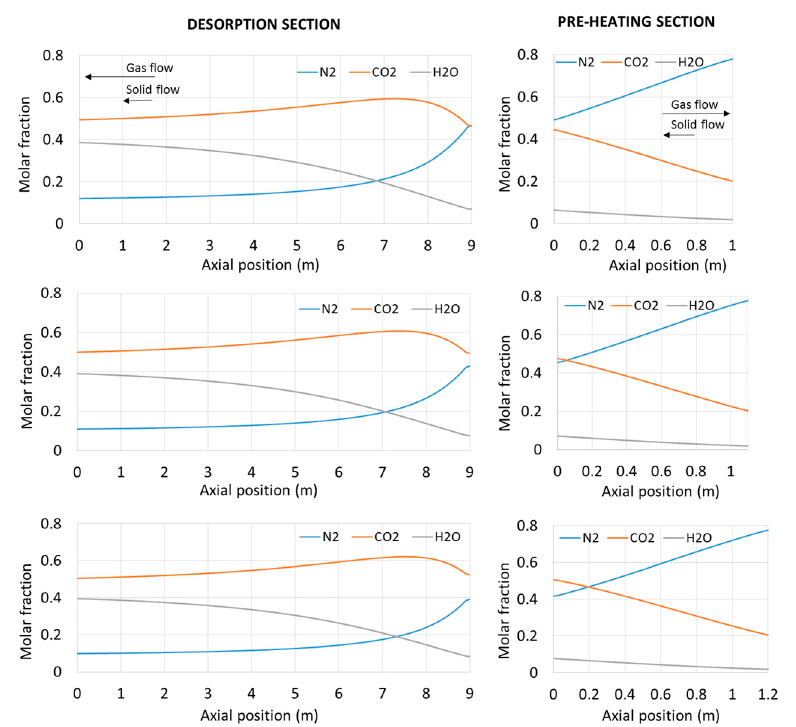
Figure 5. Gas composition profiles in desorption and preheating sections. Comparison of different lengths of the preheating section (1.0 (D-7) ( top ), 1.1 (D-8) ( center ), and 1.2 m (D-10) ( bottom